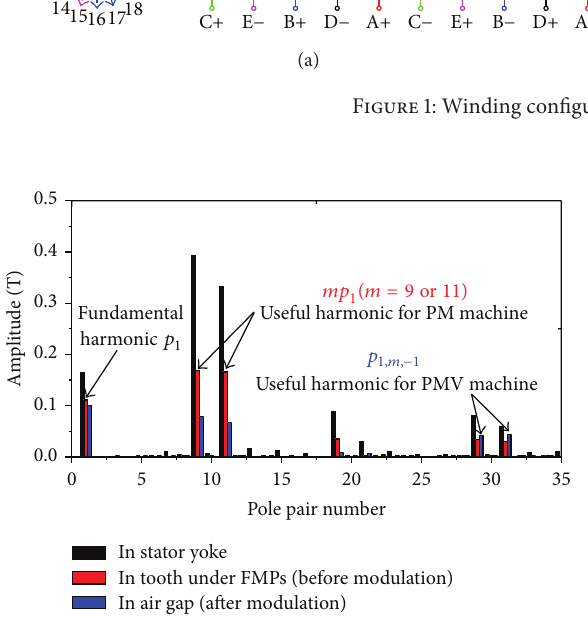
Figure 2: Space harmonic spectrum due to armature windings.